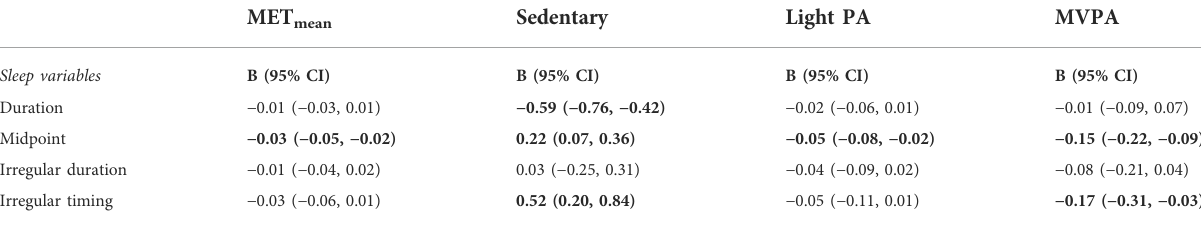
TABLE 3 Multiple regression analyses showing associations between sleep measures and physical activity